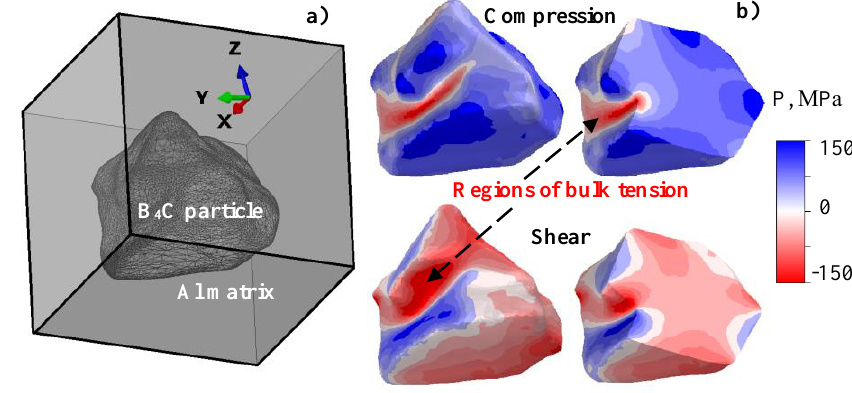
Fig. 2. Microvolume with single particle (a) and formation of local regions of bulk tension under compression and pure shear of the composite (b). Volume fraction of the particle is 20